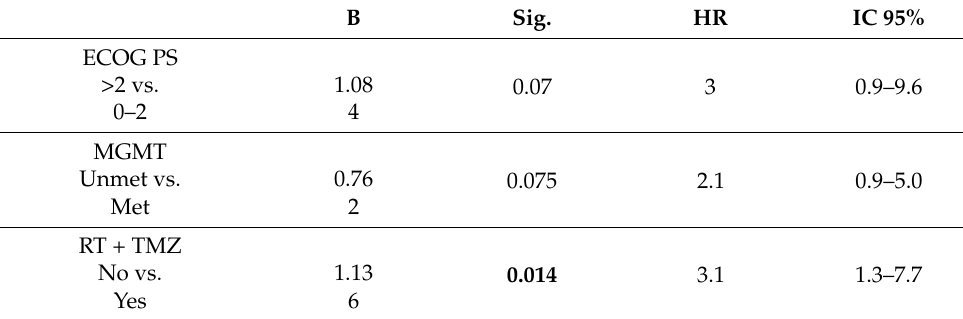
Table 4. Multivariate Analysis for OS with Cox regression. B